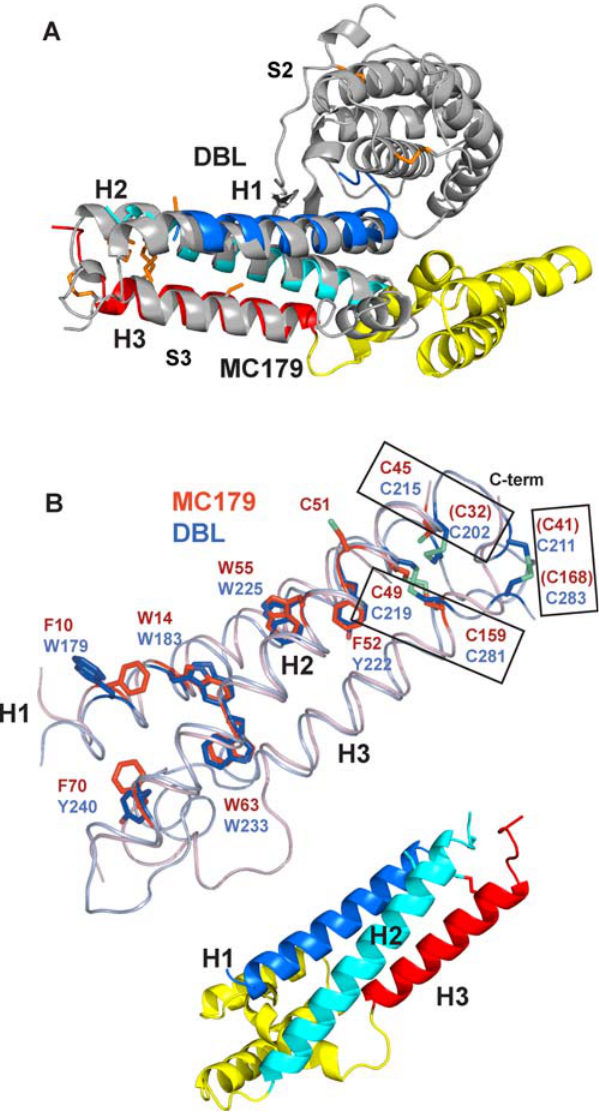
Figure 5. CIDR and DBL domains have structurally identical three-helix bundles. (A) The three-helix bundle of MC179 closely overlays the C-terminal three-helix bundle of the F1 DBL domain of EBA-175 (gray). MC179 superimposes similarly on the F2 DBL domain of EBA-175 and the Pk a -DBL domain (not shown). Note that the connecting helices (yellow) extend between H2 and H3, but the DBL subdomain–subdomain interaction is approximately 120 u away be- tween the H1 and H2 helices. This overlay models our prediction of the DBL1 a C-terminal three-helix bundle, with the yellow connecting helices of MC179 modeling the predicted connecting helices of DBL1 a (see text). DBL subdomain 2 (S2) and subdomain 3 (S3) are labeled [41]. (B) The three-helix bundles of MC179 (pink helices) and of the F1 DBL domain (steel blue helices) are superimposed, after an approximate 180 u reorientation from (A) about the vertical axis. The connecting helices between H2 and H3 are not shown for clarity. Note the almost identical positions of the helices and of conserved Phe, Trp, Tyr, and Cys side chains (red, MC179; blue, F1 DBL). Cysteines making conserved disulfide bonds (rectangles) are from MC179 (red font) and from the F1 DBL domain (blue font). Parentheses enclose the three cysteines not observed in the MC179 electron density. Cartoon diagram serves as a reference for the orientation of MC179 in (B).